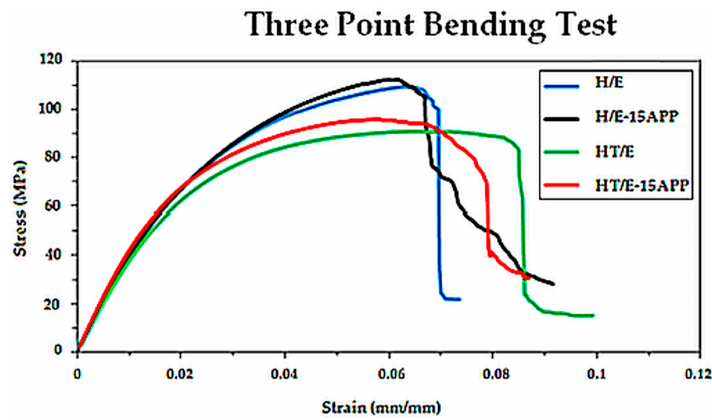
Figure 10. Stress-strain curves for the four types of composites: H/E sample, H/E-15APP sample, HT/E sample, HT/E-15APP sample.